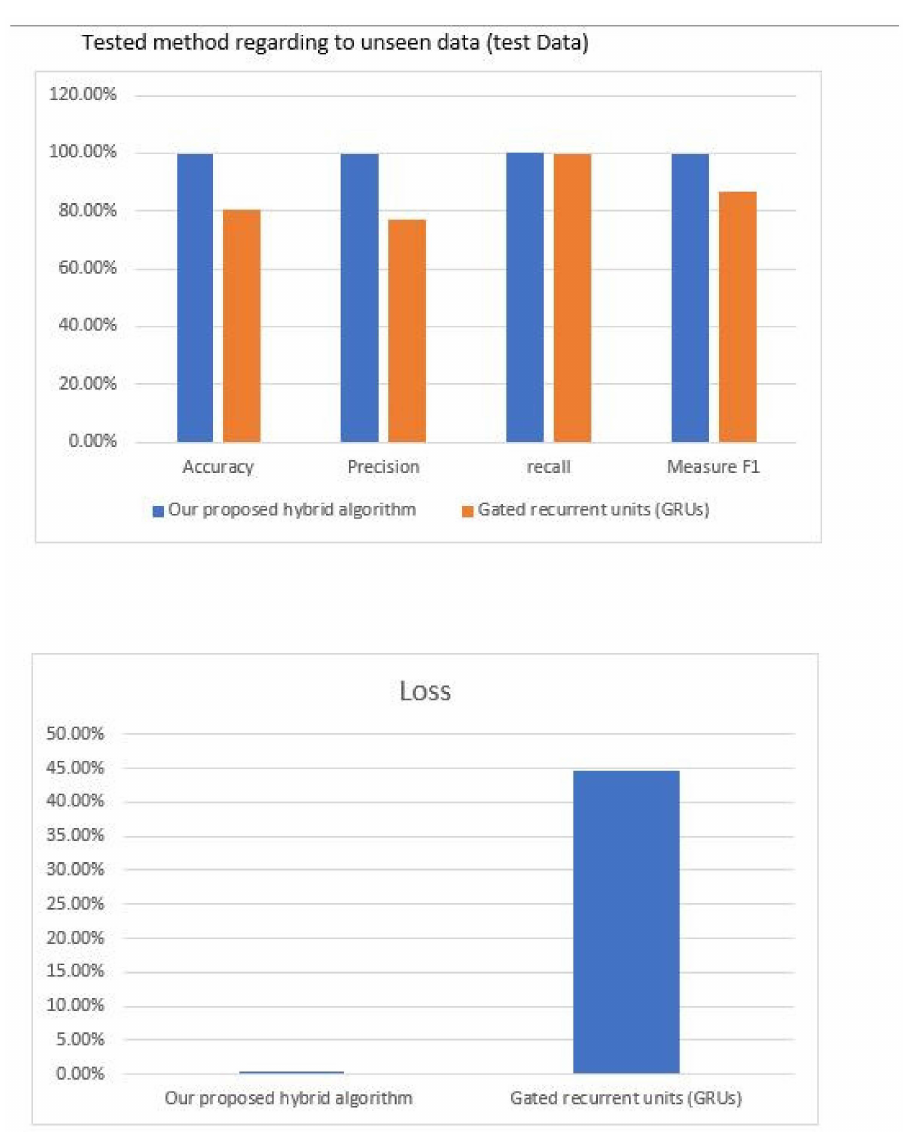
Figure 13. The results of our proposed hybrid method with the GRU method regarding the gener- ated